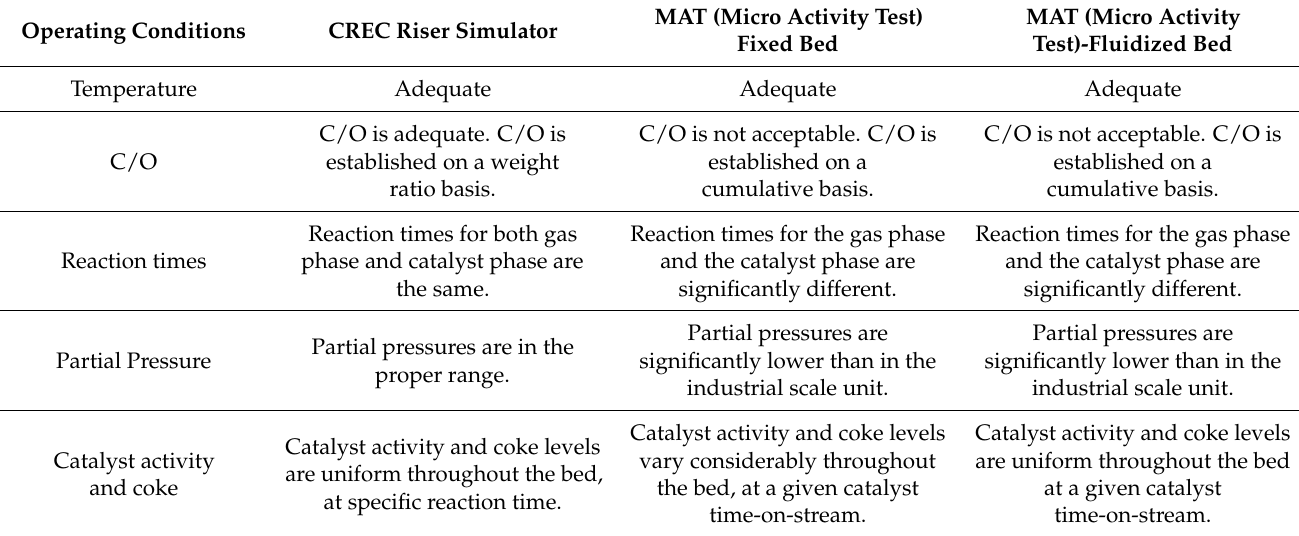
Table 2. Range of Operating Conditions in Bench Scale Laboratory Reactors to Achieve Riser/ Downer